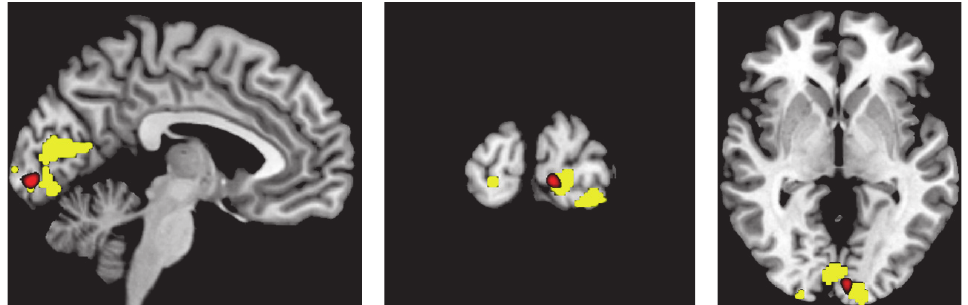
Figure2:Structuralalterationsandfunctionalactivityfollowingcheckerboardstimulation.FunctionalMRIactivation(yellow,MNI: 𝑥 = −24 , < 0.001 ; 𝑇 = 14.56 ) and VBM detected gray matter increase (red, MNI: 𝑥 = −6 , 𝑦 = −93 , 𝑧 = −3 ; 𝑝 𝑦 = −94 , 𝑧 = −12 ; 𝑝 FWE 𝑇 = 5.08 ) superimposed on skull striped anatomical (T1) image. GM increase and maximum BOLD signal are closely located in the primary visual